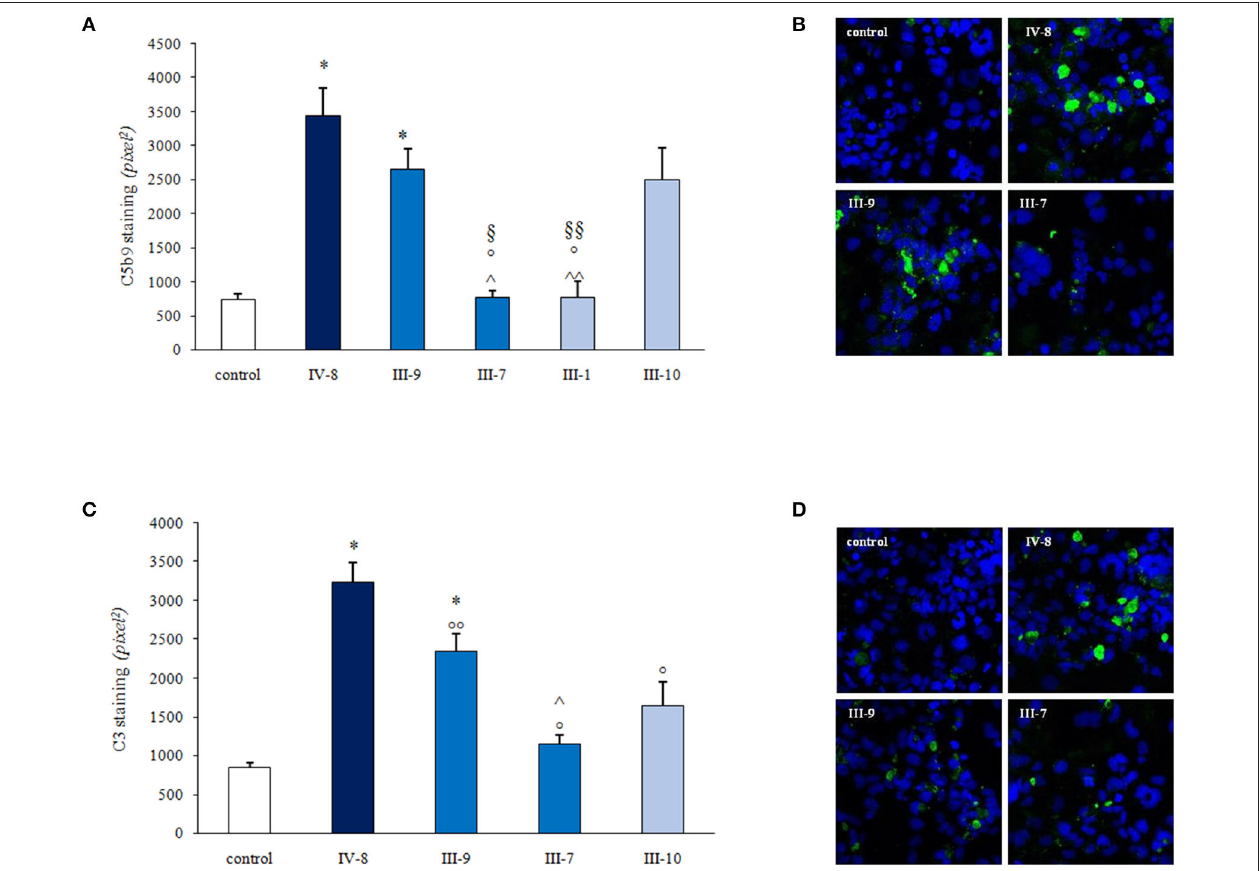
FIGURE 5 | Serum-induced C3 and C5b-9 deposition on human microvascular endothelial cell line (HMEC-1) activated with adenosine 5 ′ -diphosphate (ADP). (A,C) Histograms show the quantification of C5b9 (A) or C3 (C) staining on activated HMEC-1 after 4h of incubation with the serum from a healthy control (control), the patient (IV-8; heterozygous for CD46 c.286 + 2T > G variant), patient’s father (III-7; homozygous for CD46 c.286 + 2T > G variant), the patient’s mother (III-9; with no complement RVs), a paternal relative (III-1; heterozygous for CD46 c.286 + 2T > G variant), and a maternal relative (III-10; with no complement RVs). Data are means ± SE; * P < 0.0001 vs. control; ◦ P < 0.0001 vs. IV-8; ◦◦ P < 0.01 vs IV-8; ∧ P < 0.0001, ∧∧ P < 0.001 vs. III-9; § P < 0.01, §§ P < 0.05 vs. III-10. Representative confocal microscopy images show strong C5b-9 (B) and C3 (D) staining (green) on activated H-MEC1 induced by serum from the patient (IV-8) and from his unaffected